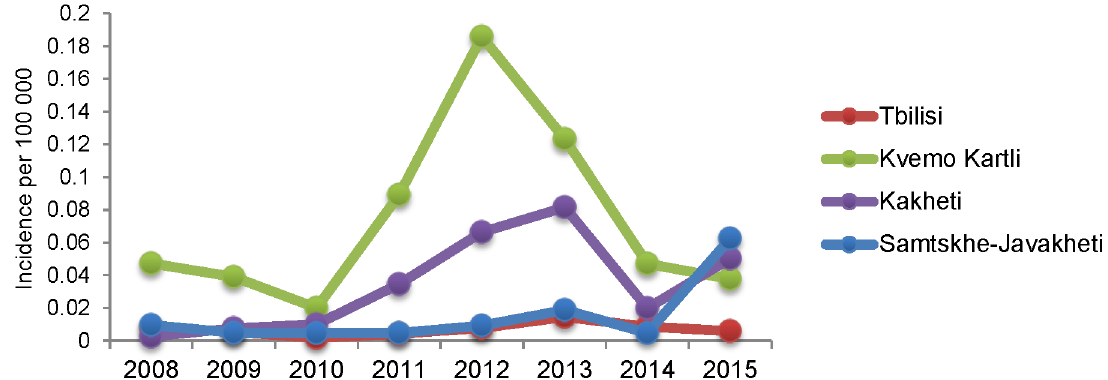
Fig 1. Incidence of human cutaneous anthrax in the most affected regions of Georgia, 2008–2015. National cumulative incidence rates from 2008 to 2015 was calculated per 100 000 population by geographic location. Three regions with the highest incidence rate and incidence rate in the capital city (Tbilisi) are presented on the line chart. The graph describes the increase in incidence in 2012–2013 years.